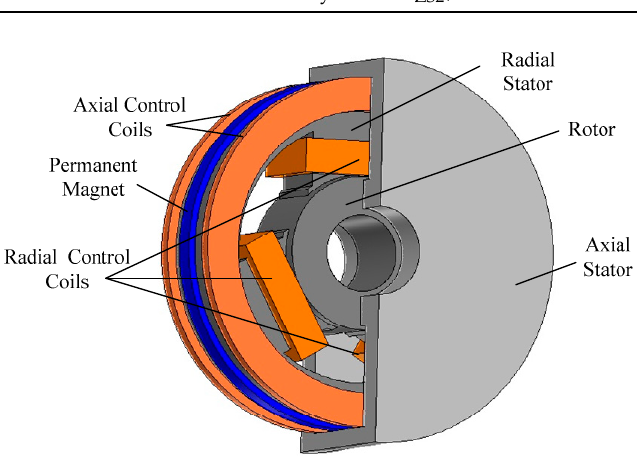
Figure 3. The 3 ‐ D finite element method (FEM) model of three ‐ pole radial ‐ axial hybrid magnetic Figure 3. The 3-D finite element method (FEM) model of three-pole radial-axial hybrid magnetic bearings (HMB). bearings